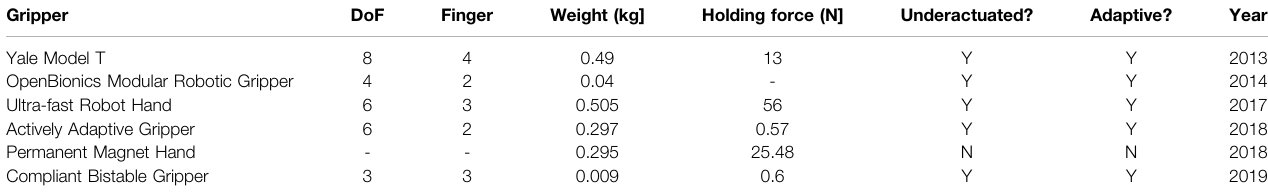
TABLE 2 | Comparison of different characteristics of the examined aerial grippers.